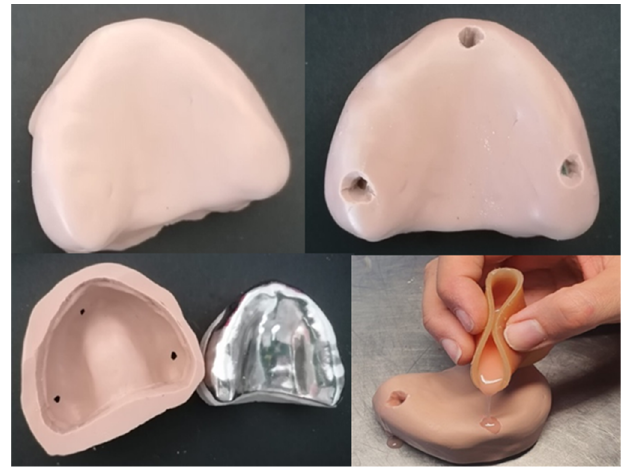
Figure 5. Self-curing acrylic bases fabrication.